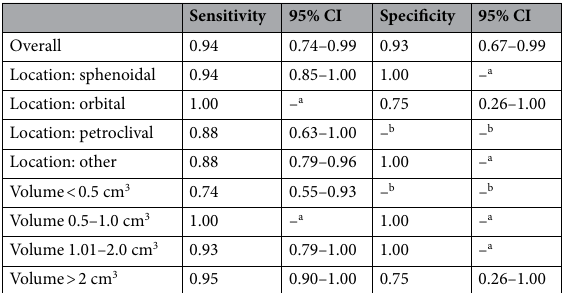
Table 2. The table demonstrates the overview of specificity and sensitivity dependent on location and size for MRI. a Lack of information due to perfect fit. b Lack of information due to sparse